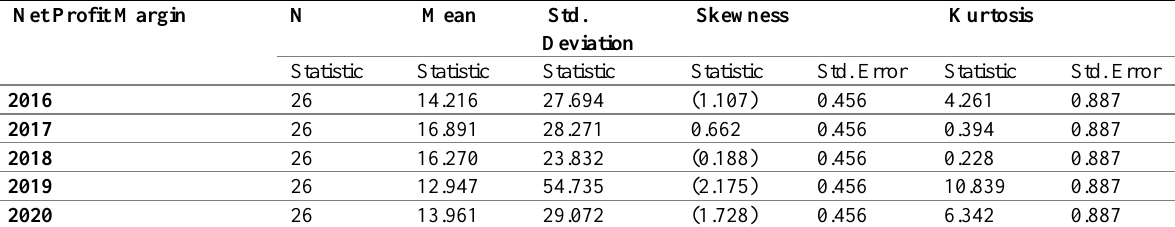
Table 1: Net Profit Margin Descriptive Results